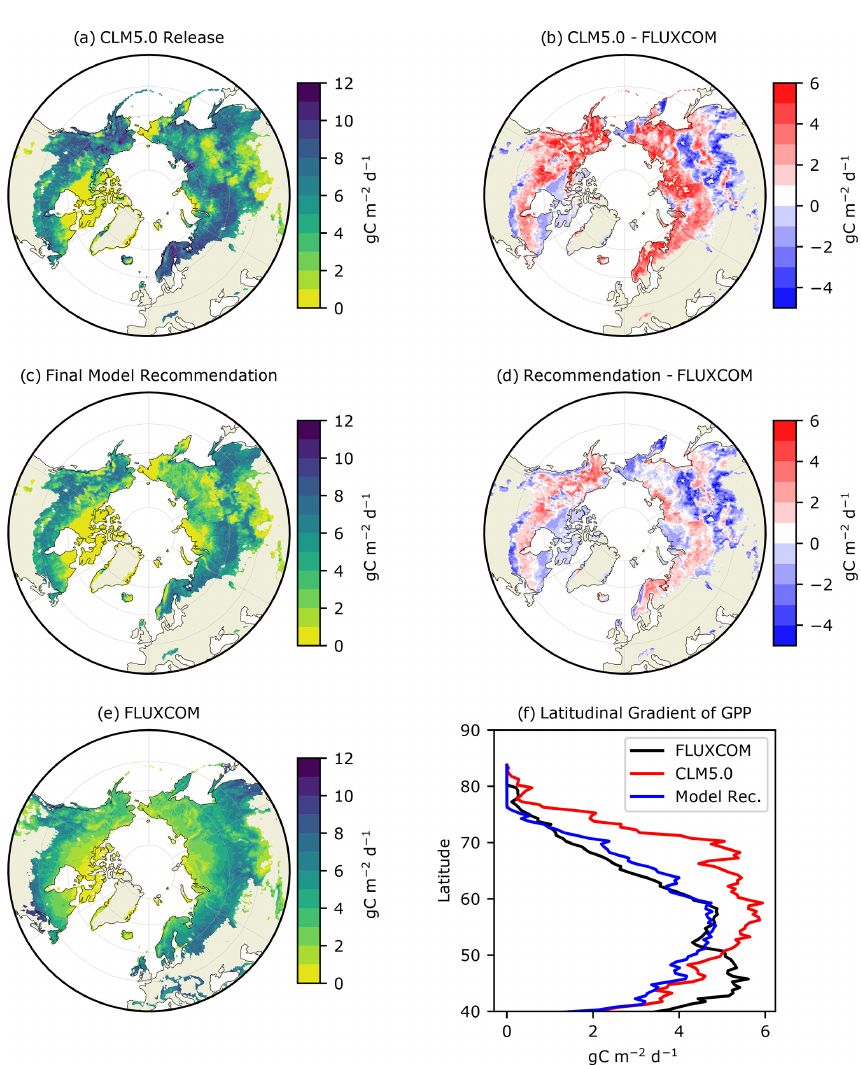
Figure 1. Average summer (JJA) GPP (gCm − 2 d − 1 ) for (a) CLM5.0 release, (b) our model recommendation, and (c) FLUXCOM, with the differences between the two model simulations and FLUXCOM in (b) and (d) . The latitudinal gradient of summer GPP is depicted in (f) .